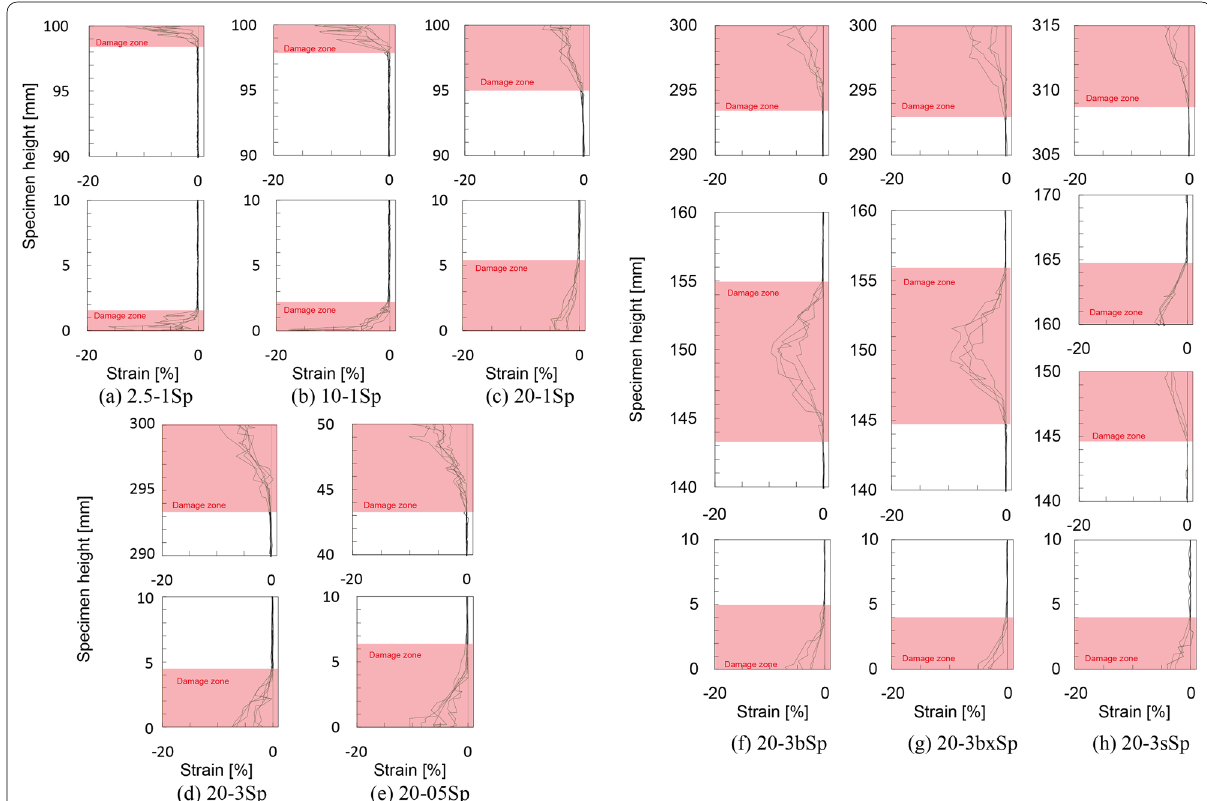
Fig. 10 Longitudinal strains distribution of specimens near loading plates in 0.2 P